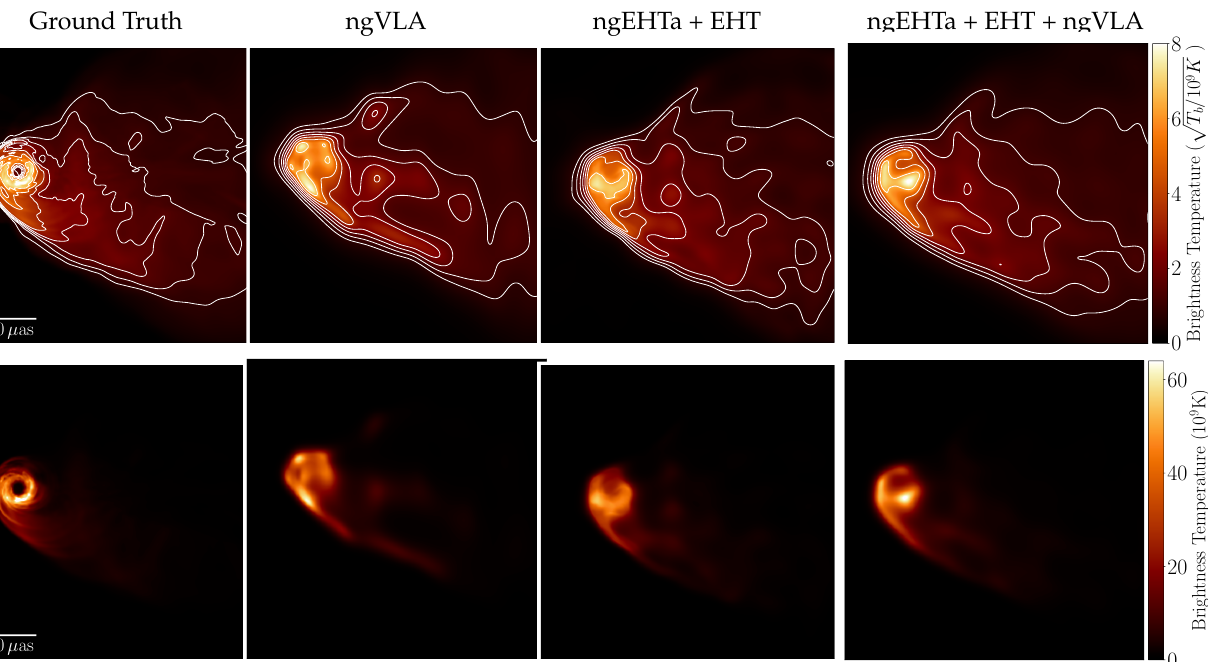
Figure 10. Demonstration of interoperability with ngVLA using simulated observations of the M87 jet at 86GHz. The columns from left to right are: the ground truth image; the reconstruction with the ngVLA only; the reconstruction with the full ngEHT array; and the reconstruction with the full ngEHT array combined with the ngVLA. Top: Images plotted in square-root scale to emphasize the jet reconstruction; the contours are spaced logarithmically, starting at 1% of the peak value and increasing by factors of 2. Bottom: Images on a linear scale to emphasize the shadow reconstruction. The sensitivity of the ngVLA improves the dynamic range of the ngEHT, and the ngEHT boosts the resolution of the ngVLA, enabling imaging of both the shadow and the jet at 86GHz with high